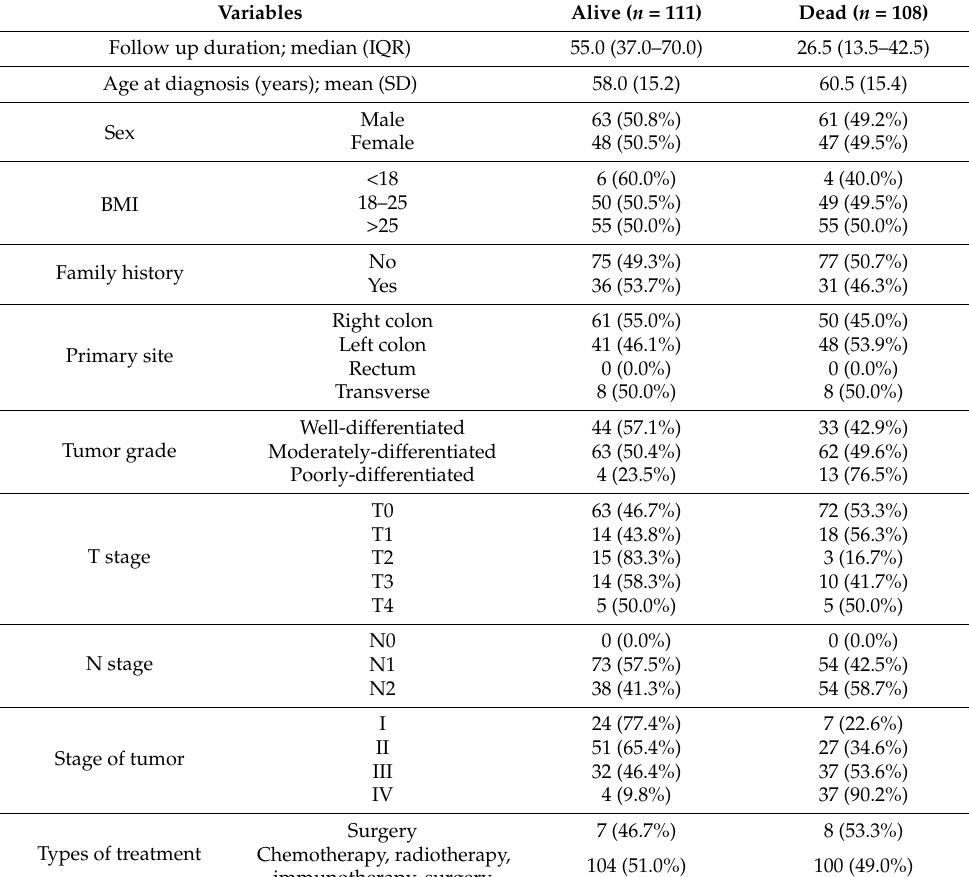
Table 3. Demographic and clinical characteristics of CRC cancers in train dataset.